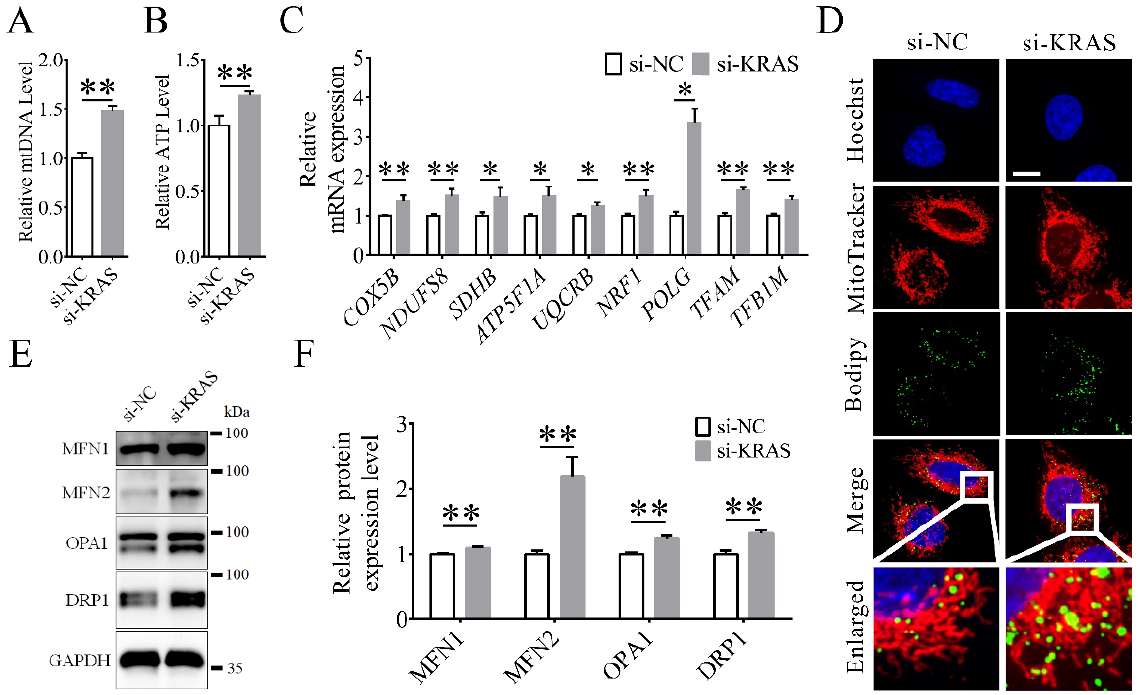
Figure 4. Effects of Kirsten rat sarcoma viral oncogene homolog (KRAS) on mitochondrial function in MAC-T cells. ( A ) Relative level of mitochondrial DNA (mtDNA) copy number in MAC-T cells with or without KRAS inhibition. ( B ) Relative ATP level in MAC-T cells with or without KRAS inhibition. ( C ) Relative mRNA expression levels of cytochrome c oxidase subunit 5B ( COX5B ), NADH:ubiquinone oxidoreductase core subunit S8 ( NDUFS8 ), succinate dehydrogenase complex iron sulfur subunit B ( SDHB ), ATP synthase F1 subunit alpha ( ATP5F1A ), ubiquinol–cytochrome c reductase binding protein ( UQCRB ), nuclear respiratory factor 1 ( NRF1 ), DNA polymerase gamma catalytic subunit ( POLG ), mitochondrial transcription factor A ( TFAM ), and mitochondrial tran- scription factor B1 ( TFB1M ) in MAC-T cells with or without KRAS inhibition. ( D ) Representative Hoechst, MitoTracker, and Bodipy fluorescence images in MAC-T cells with or without KRAS inhi- bition. Bar = 10 μm. ( E , F ) Representative Western blot images and relative protein expression levels of mitofusin (MFN)1, MFN2, optic atrophy 1 (OPA1), and dynamin-related protein 1 (DRP1) in MAC-T cells with or without KRAS inhibition. Significant differences are represented with * ( p < 0.05) and ** ( p < 0.01).